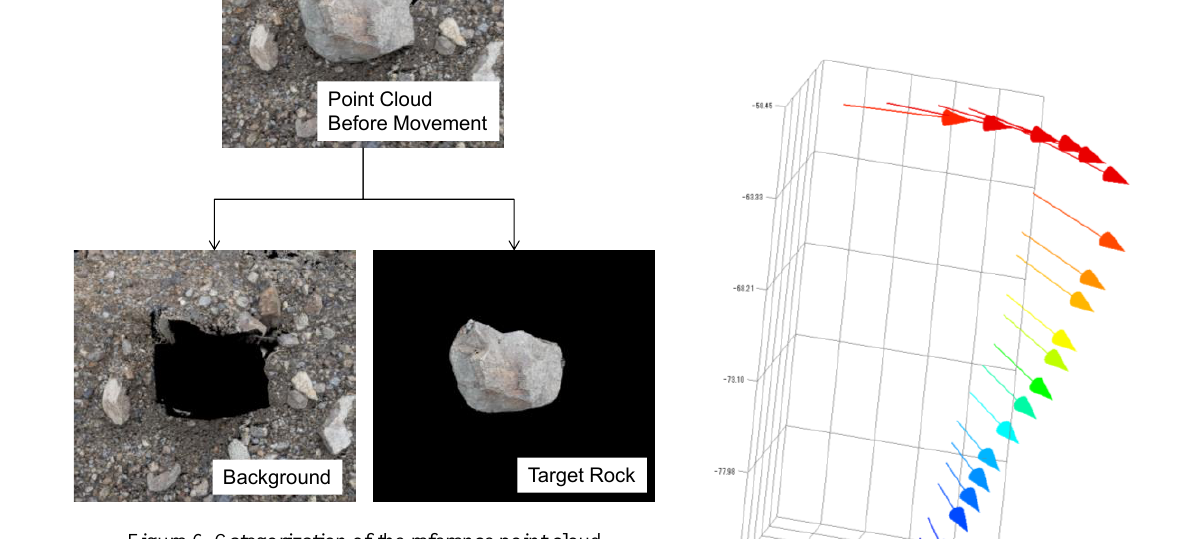
Figure 6. Categorization of the reference point cloud